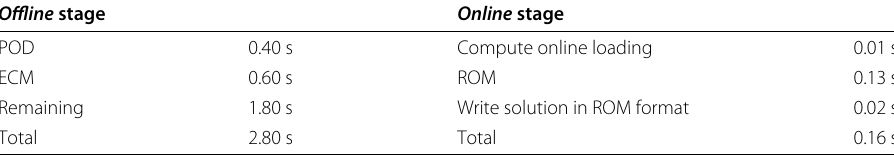
Table 2 Simple test case with radiation only using Z-set (durations for the offline and online